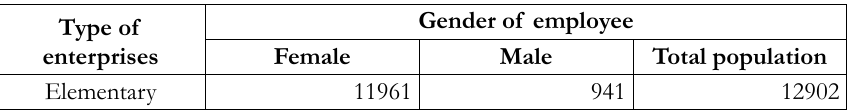
Table 1. The total number of small employee medium sized enterprises of 19